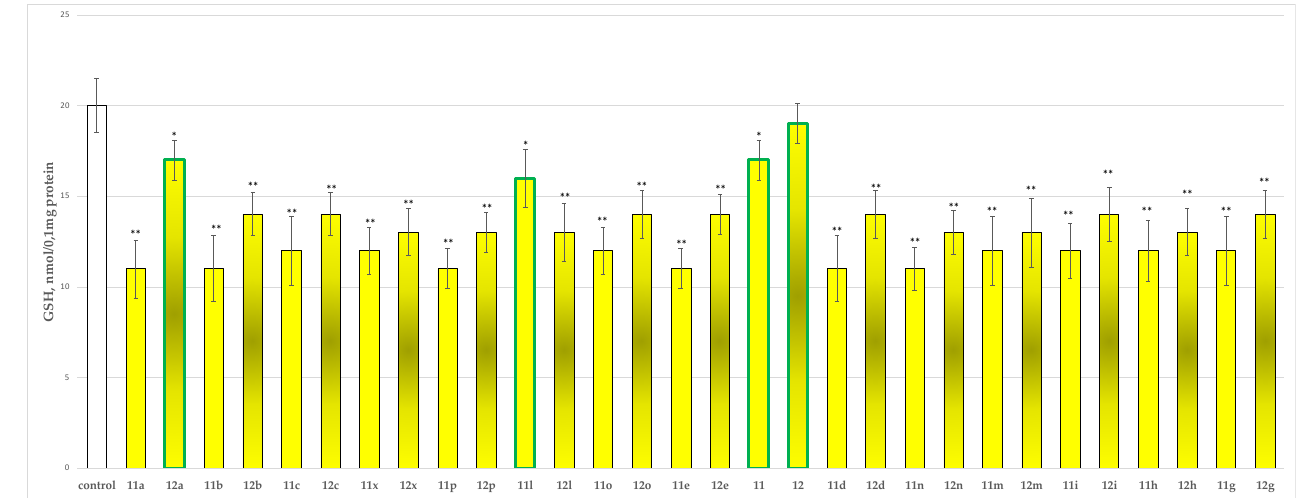
Figure 5. Effects of compounds 11 , 11a – 11x , 12 and 12a – 12x (100 µ mol), applied alone, on the reduced GSH levels. * p < 0.05; ** p < 0.01 against the control (untreated synaptosomes). The green outline indicates the most promising derivatives.